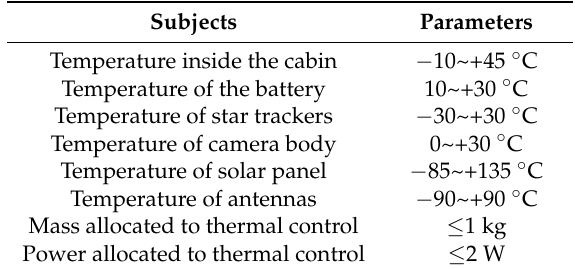
Table 6. Parameters of TCS design requirements in general.